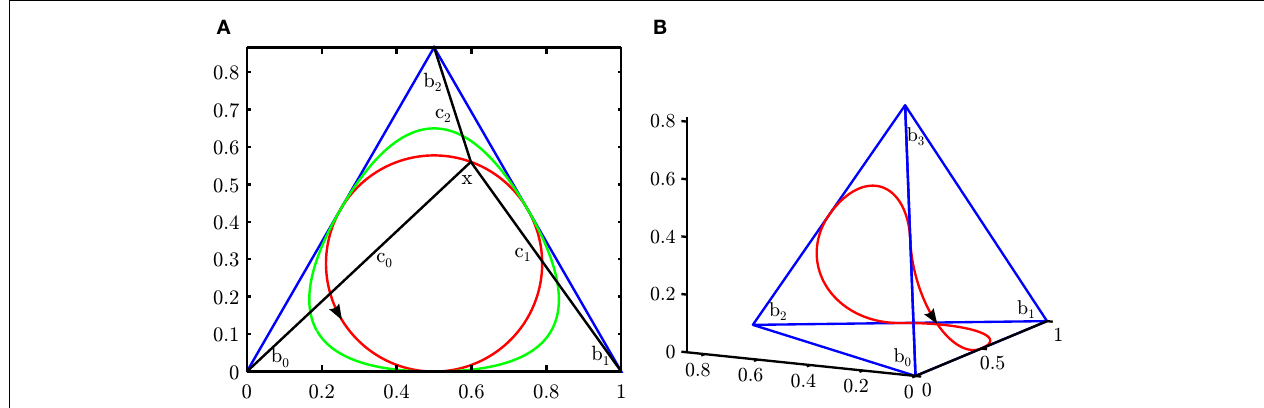
FIGURE 2 | (A) 2-simplex. Blue: edges of a simplex. Red curve: trajectory from cos 2 -encoded single measurements. Green: B-spline-encoded single measurements. (B) 3-simplex. Blue: edges of simplex. Red: cos 2 -encoded single measurements.